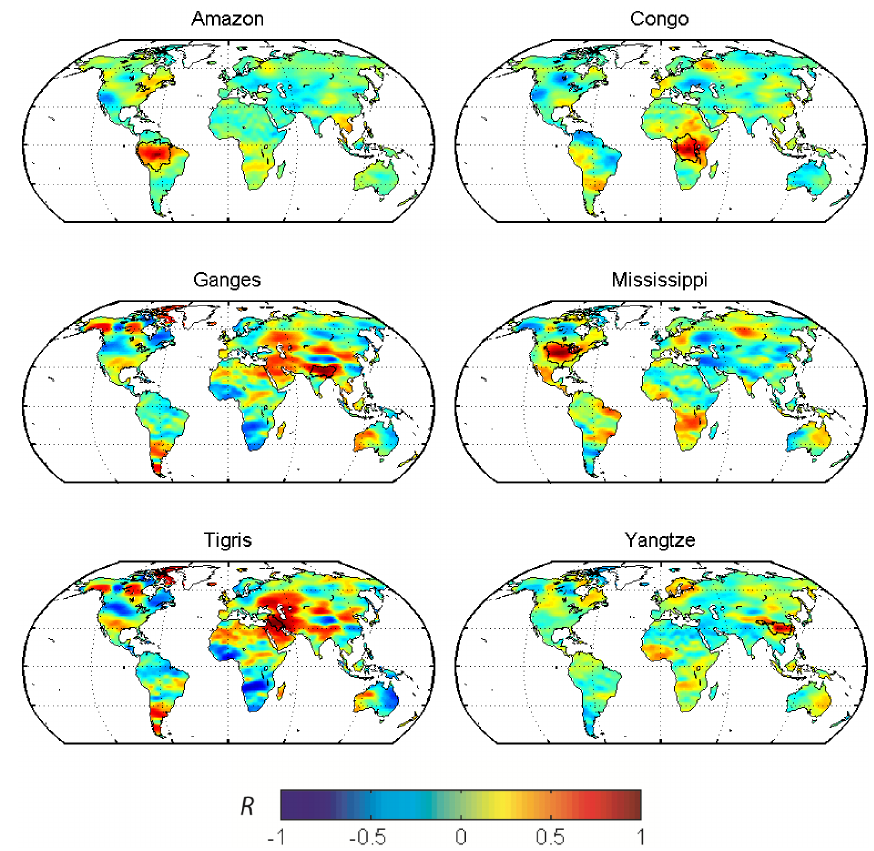
Figure 2. Patterns of connection inferred from GRACE TWSA for six river basins, in which connection pattern is based on correlation between the basin centroid and all other cells in the